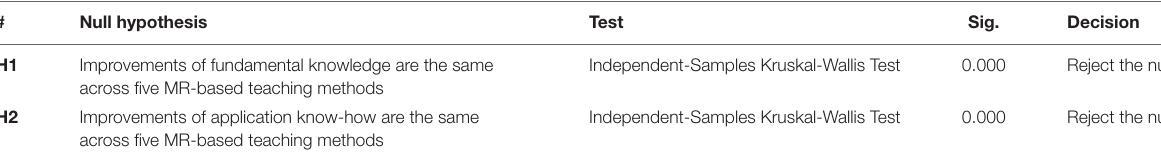
TABLE 6A | Kruskal–Wallis one-way ANOVA test for Hypothesis 1.